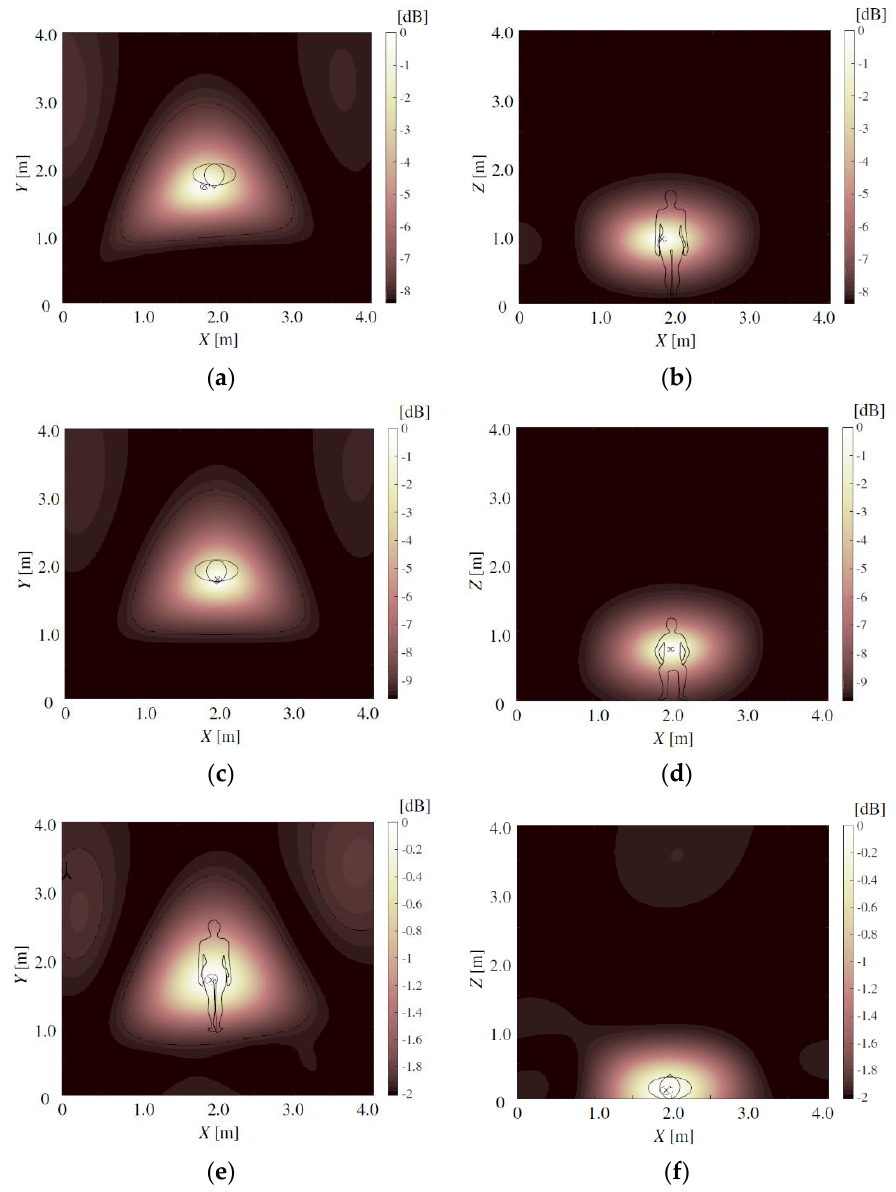
Figure 11. Multiple signal classification (MUSIC) spectrum with a person ( a , b ) standing, sitting on a chair( c , d ), and ( e , f ) lying on the floor [49].